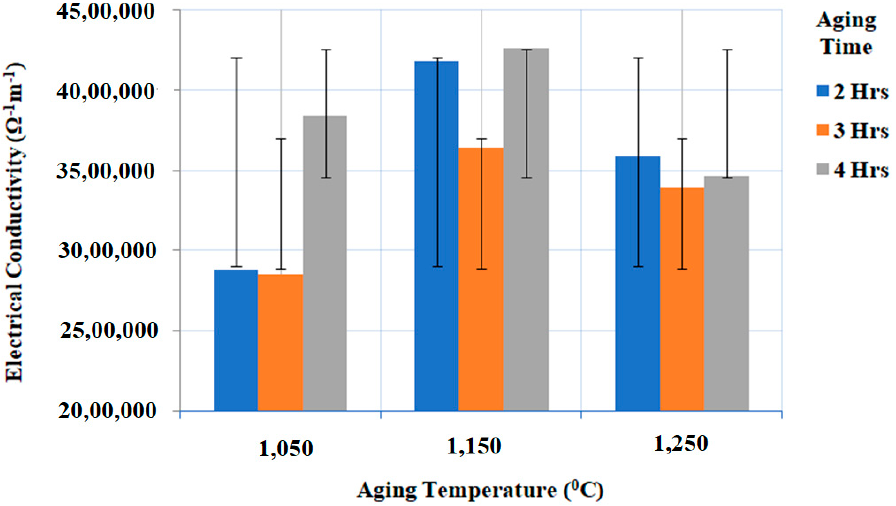
Figure 8. Experimental results of electrical conductivity ( Ω − 1 m − 1 ) under different aging tempera- tures (°C) and aging times (h) with the constant heating rate (°C/min), and cooling rate (°C/min).